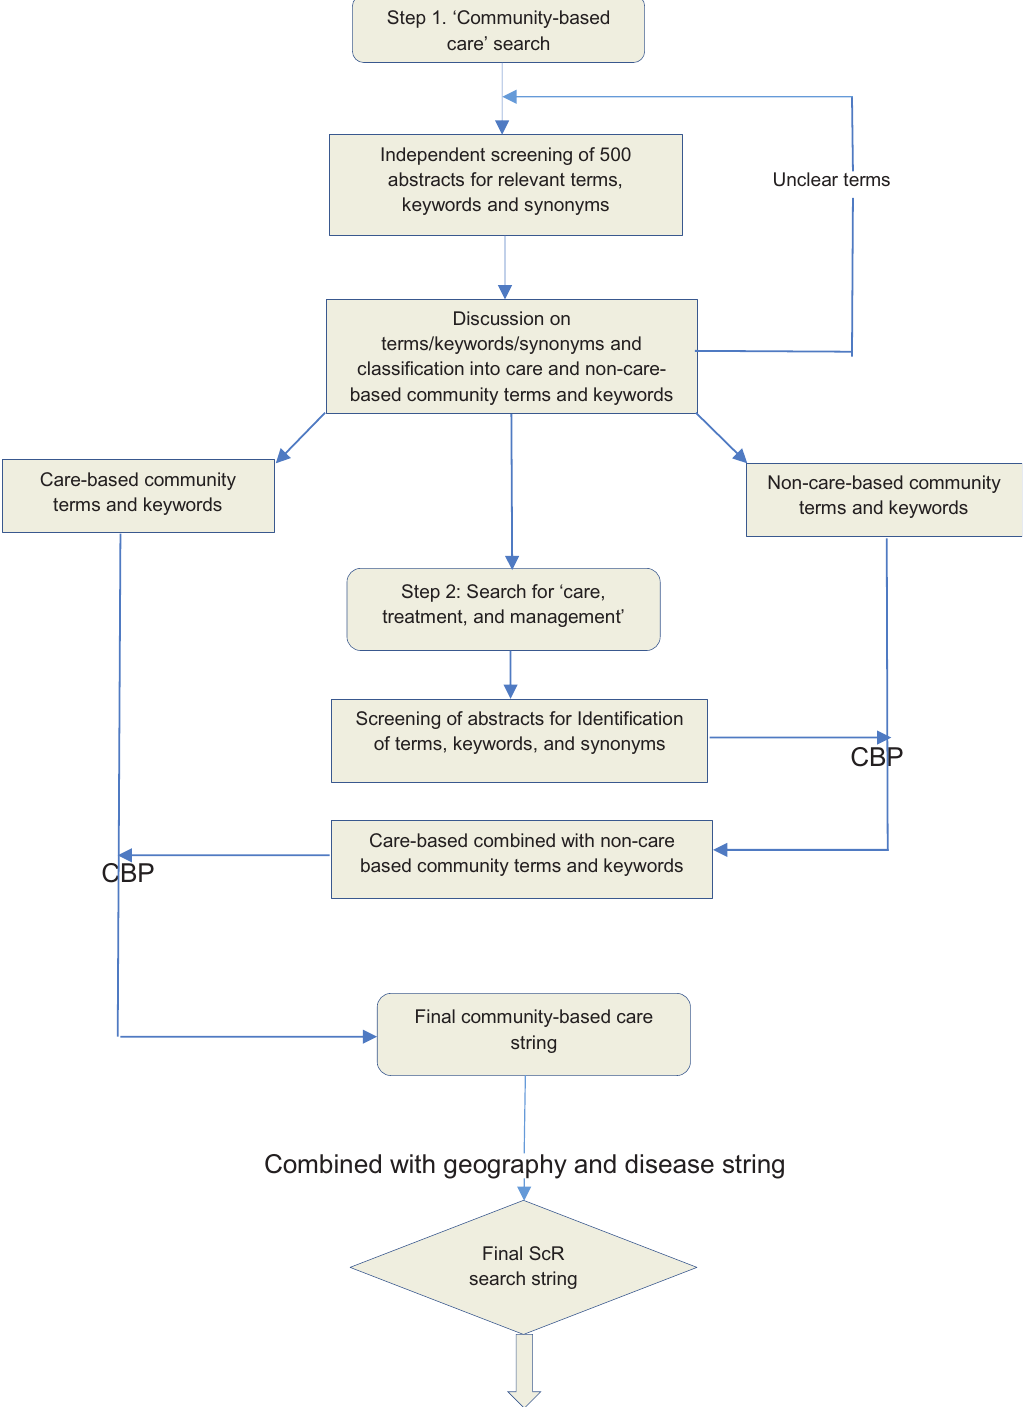
Figure 1. Flow diagram of search and study selection process. CBP = combined with Boolean and proximity operators. ScR = scoping